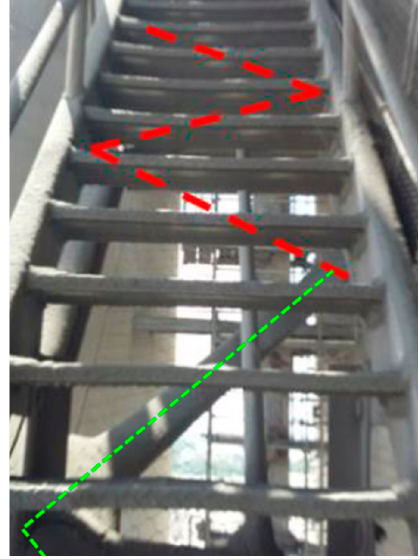
Figure 4. Missing structural joints.